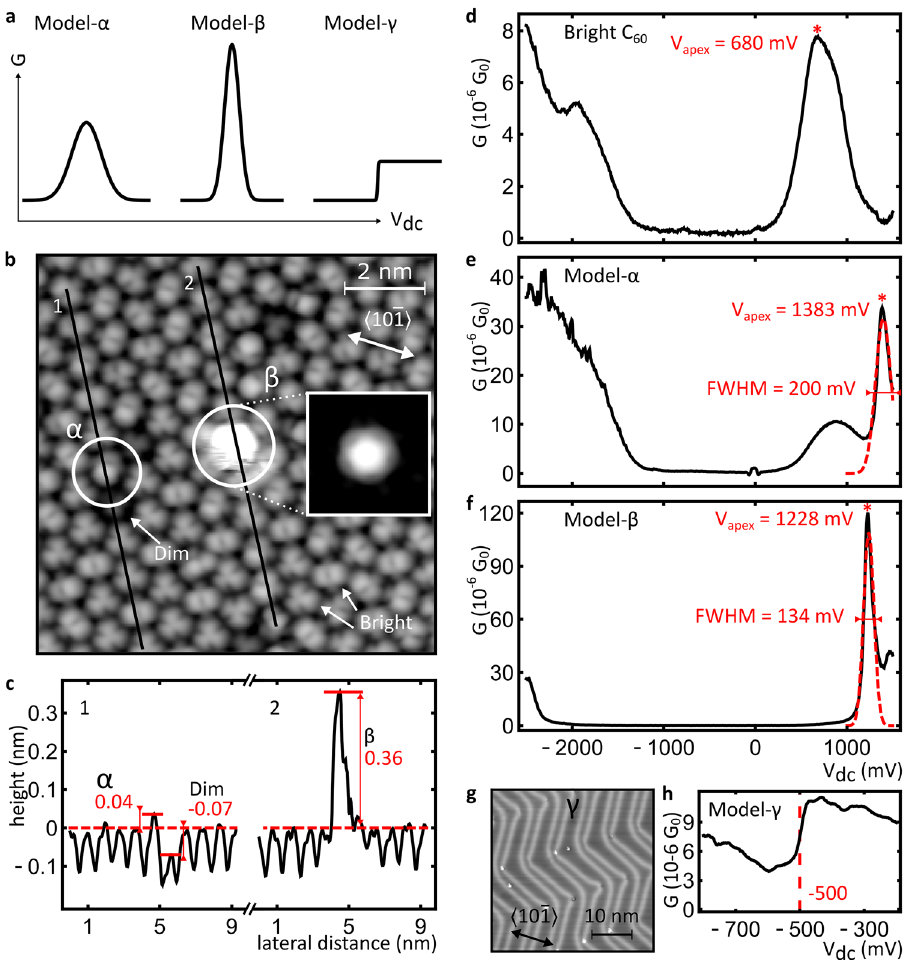
Figure 1. Details of the model systems ( a ) A schematic representation of the different voltage dependences of the conductance of models α, β and γ. ( b ) STM image (0.15 nA; + 1310 mV; 0.25 nm z-scale) of a C 60 island on Au(111). Example dim and bright C 60 molecules are indicated with labelled arrows; a model-α and a model-β molecule are indicated with labelled circles. Inset shows an STM image (0.31 nA; + 1273 mV; 0.40 nm z-scale) with contrast optimised to resolve intramolecular details of model-β. ( c ) Height profiles along the black lines as labelled in b. The height values of model-α, model-β and dim molecules relative to bright C 60 are indicated and dashed lines indicate the average height of bright C 60 . ( d ) Typical G ( V DC ) spectrum of bright C 60 . ( e , f ) Typical G ( V DC ) spectra of model-α and model-β. The red dashed lines indicate Gaussian fits to the sharp peaks used in RF measurements. ( g ) STM image (0.30 nA; + 533 mV; 0.08 nm z-scale) of herringbone-reconstructed Au(111); an fcc region is marked by γ. h) Typical G ( V DC ) spectrum of model-γ (average of five spectra; recorded over an 5 S 2 e / h 7.75 10 fcc region). G 0 is the conductance − = ≈ ·